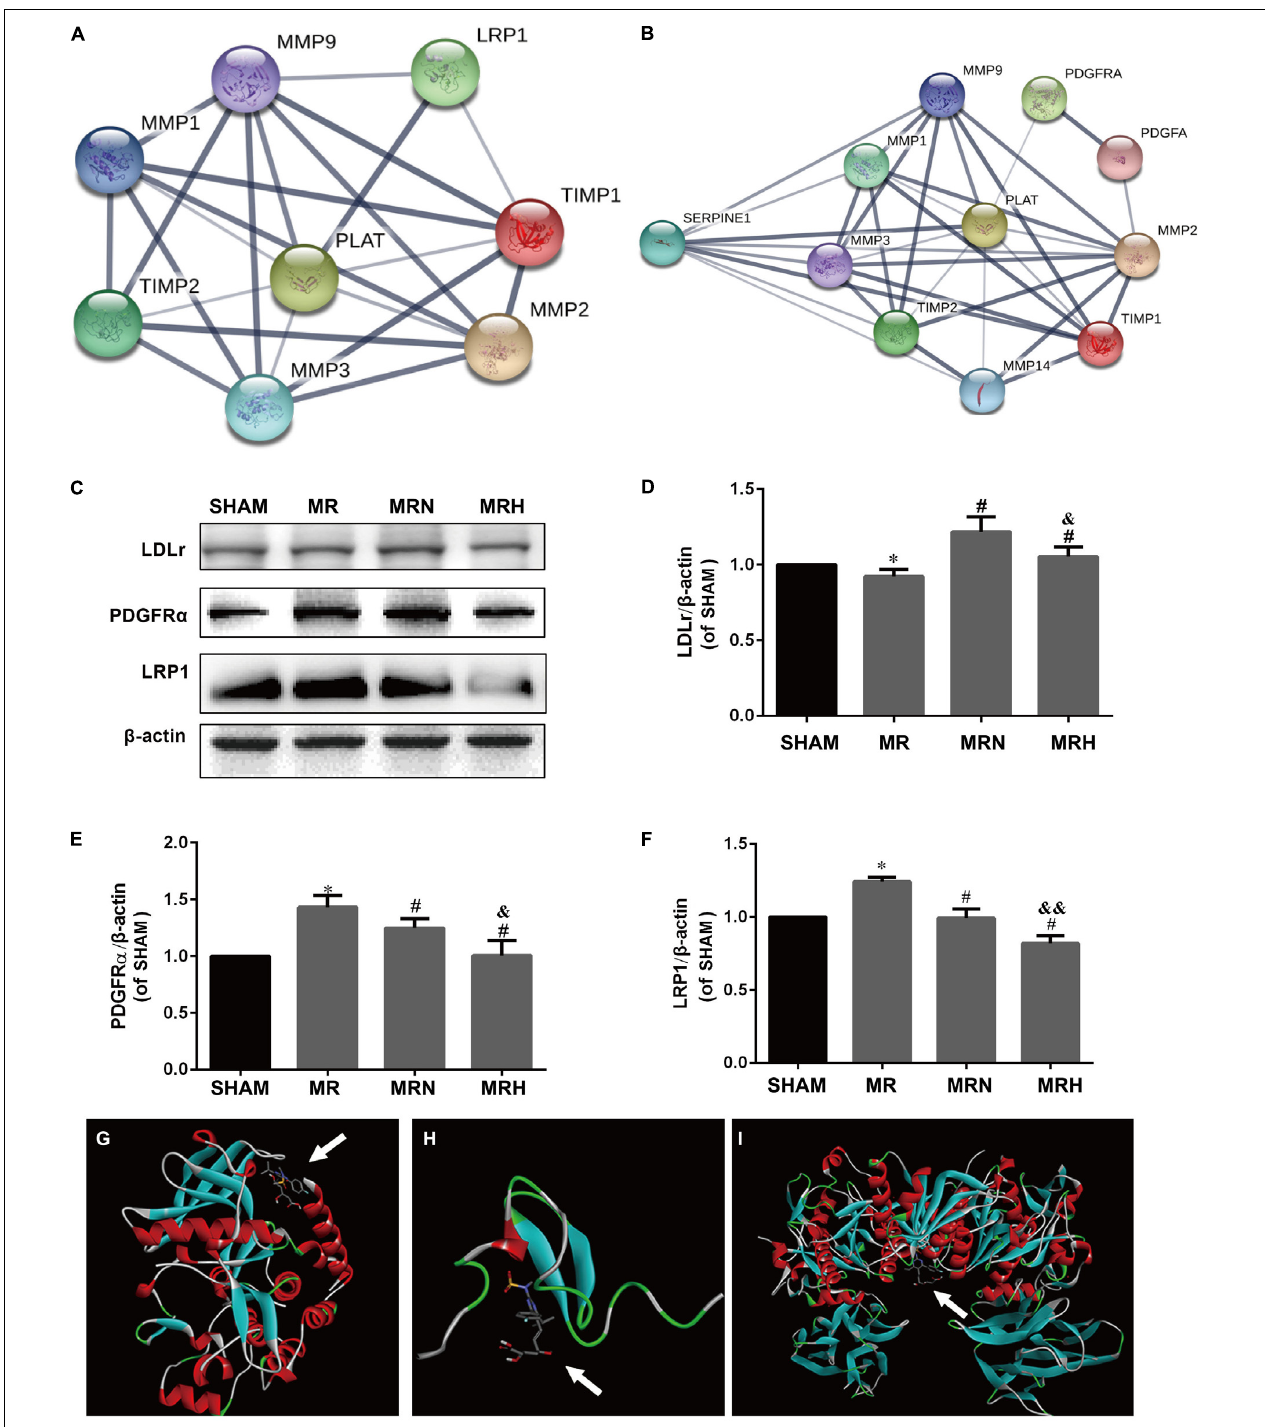
FIGURE 5 | Rosuvastatin reductions in the BBB damage induced by rt-PA-reperfusion after MCAO are associated with the expression of PDGFR- α , LRP-1, and LDLr. (A,B) The interaction networks between tPA, LRP1, PDGFR- α , TIMP-1, TIMP-2, MMP-1, MMP-2, MMP-3, and MMP-9 were searched using the STRING database. PPI scores are shown in Supplementary Table S1 . (C) The protein bands for PDGFR- α , LRP-1, LDLr, and β -actin detected using Western blotting and exposed by a Tanon 2500/2500R. (D–F) The relative densities were assessed by calculating the ratios of PDGFR- α , LRP-1, and LDLr proteins to β -actin and comparing the differences with the SHAM group ( ∗ P < 0.05), among the MRN, MRH, and MR groups ( # P < 0.05), and between the MRN and MRH groups ( & P < 0.05, && P < 0.01). Means ± SEM, n = 6. (G) The molecular docking of rosuvastatin to PDGFR- α is visualized. (H) The molecular docking of rosuvastatin to LRP-1 is visualized. (I) The molecular docking of rosuvastatin to LDLr is visualized. The affinity was calculated and is shown in Supplementary Table S2 .